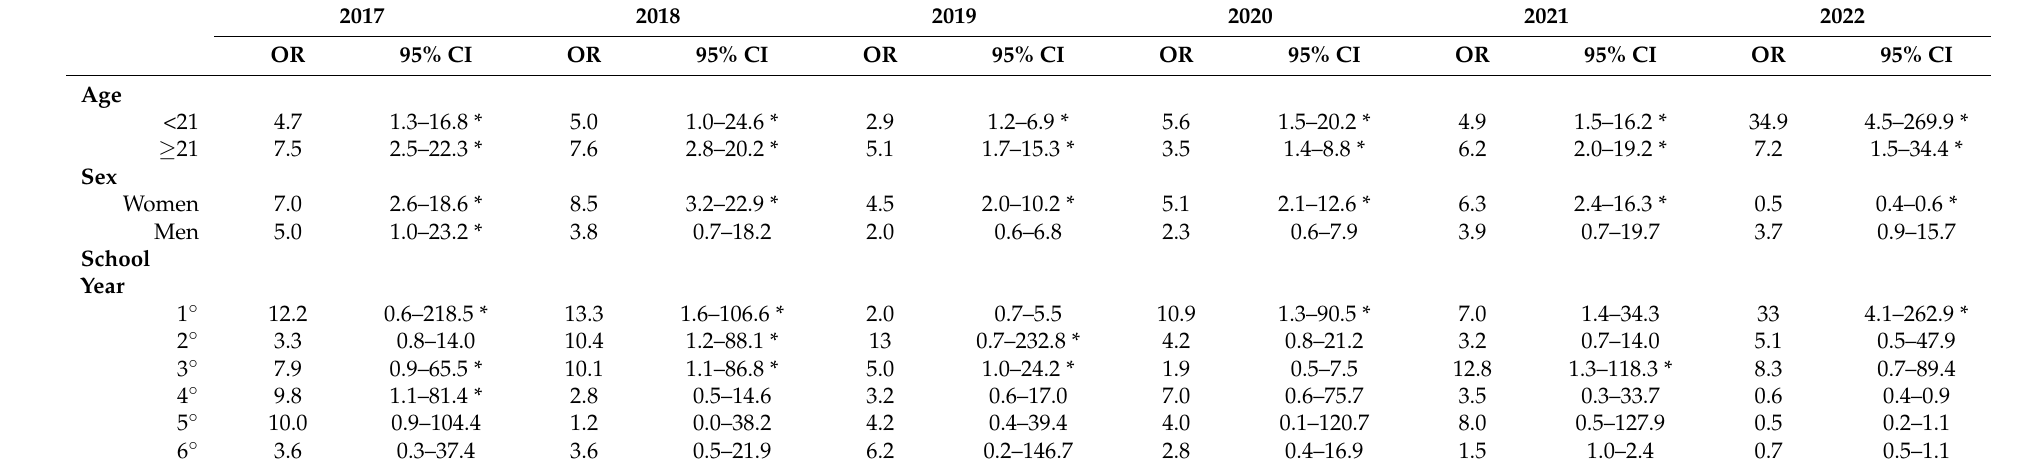
Table 4. Associations between Disordered Eating Behaviors and Body Dissatisfaction stratified by age, sex and school year